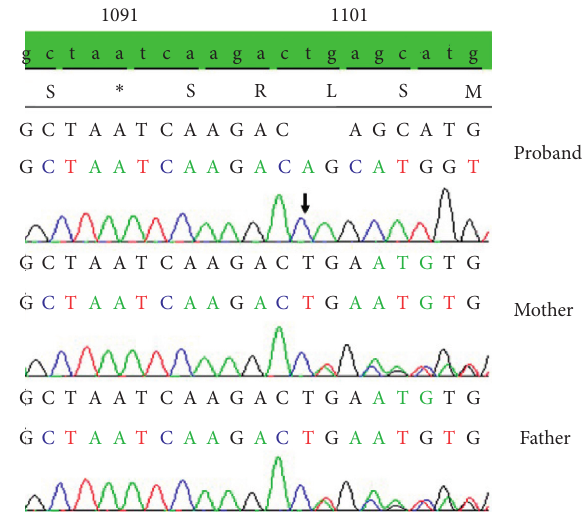
Figure 1: Confirmatory Sanger Sequencing of the VPS 33 B gene c.1098_1099delTG (p.Glu367Alafs ∗ 17) mutation from the patient and her parents